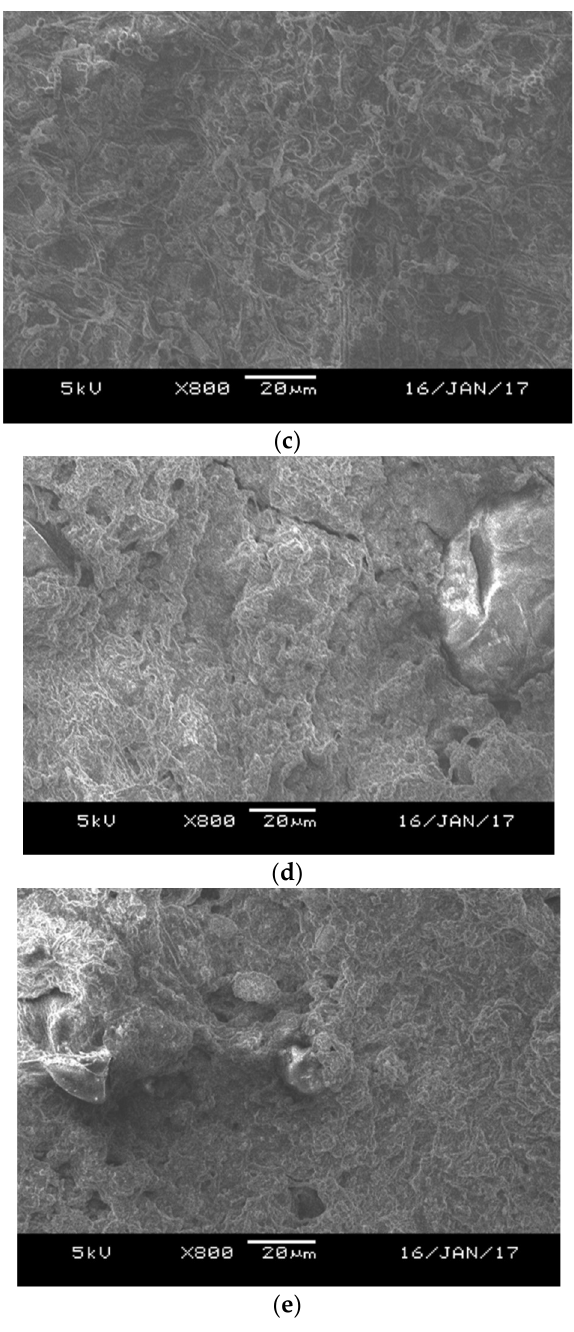
Figure 1. Scanning electron microscopy (SEM) of sludge floc ( a ) control (0 mg/L); ( b ) Al-Dosed (20 mg/L); ( c ) Al-Dosed (50 mg/L); ( d ) Al-Dosed (100 mg/L); ( e ) Al-Dosed (150 mg/L).